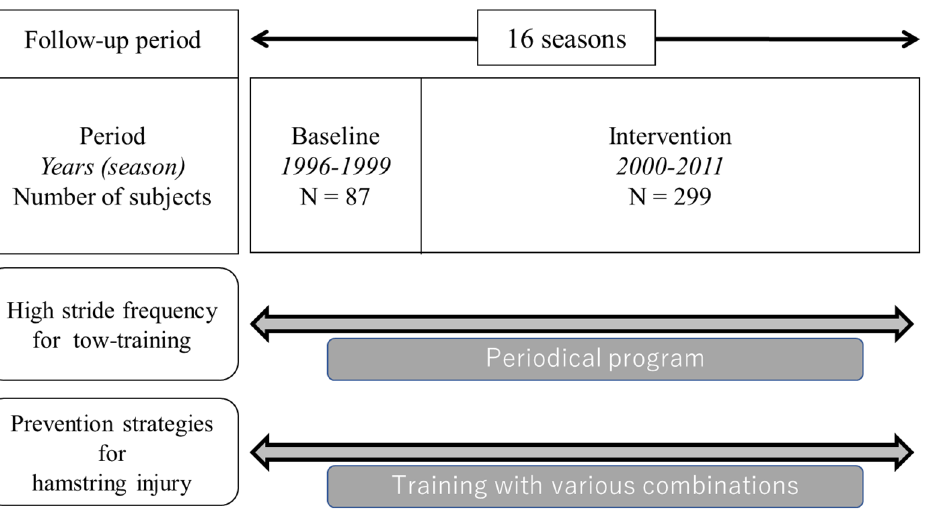
Figure 1. Study design.